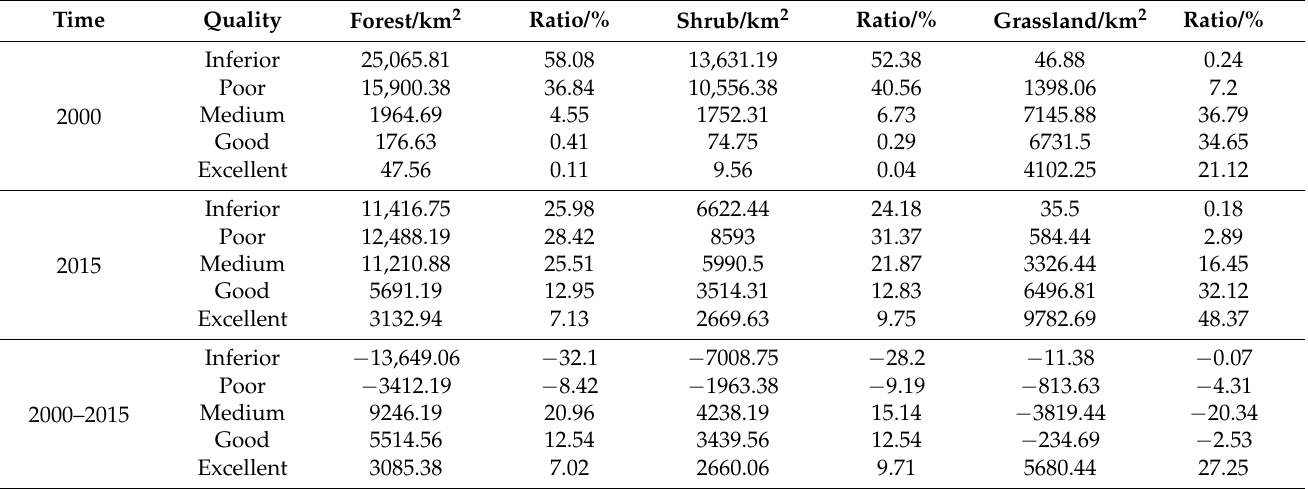
Figure 7. Classification and changes in the quality of natural ecosystem assets in the Beijing–Tianjin– Hebei urban agglomeration from 2000 to 2015.